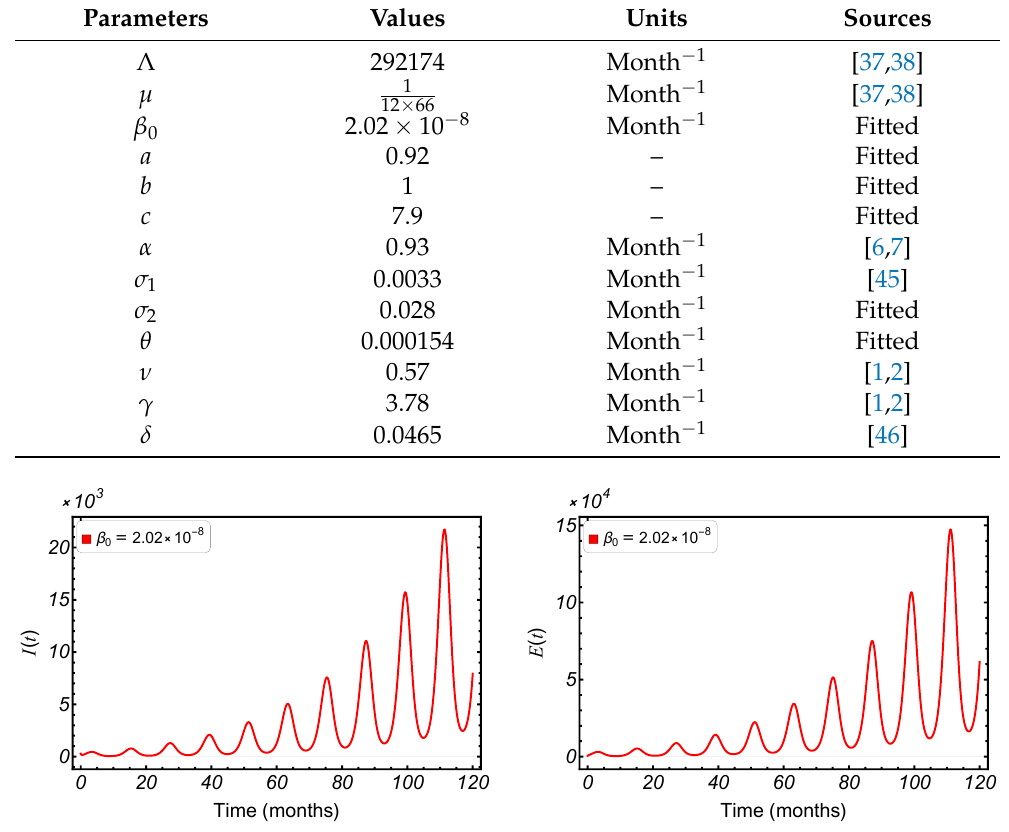
Figure 3. Persistence of measles when R 0 = 1.09938 > 1 with the parameters shown in Table